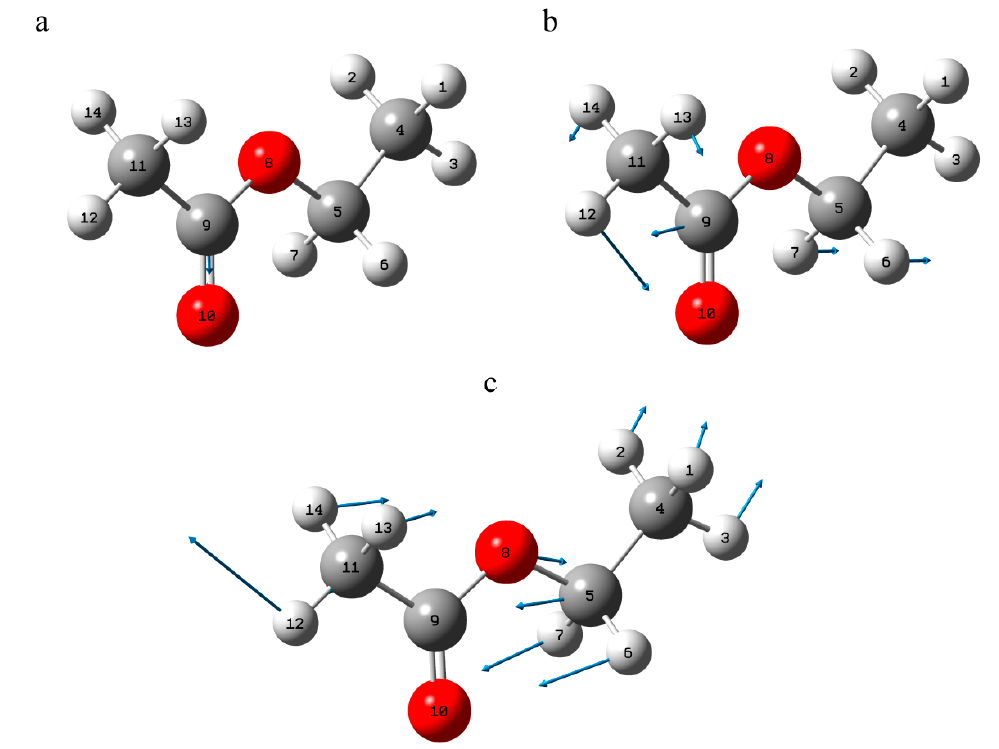
Figure 5. The most IR active vibrations in ethyl acetate molecule: 1772 ( a ), 1241 ( b ) and 1047 ( c ) cm − 1 . The broad band near 1468 cm − 1 in the experimental spectrum corresponds to three well-resolved bands, with maxima at 1495 cm − 1 , 1470 cm − 1 and 1454 cm − 1 in the calculated spectrum. These bands are related to the δ (CH 2 ) modes and the asymmetric δ (CH 3 ) modes. The coupling of such vibrational modes is due to the closeness of their frequencies, similar to situations in other organic compounds [32].